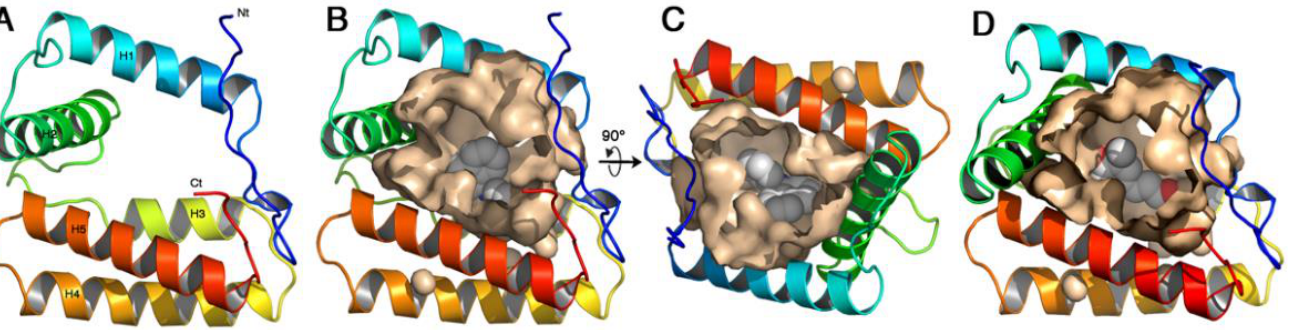
Figure 5. The homology model of TurtOBP1 obtained with Swiss-Model homology modeling [44]. ( A ) Ribbon view of the overall fold with its five α -helices. Colors are in rainbow mode from blue (N-terminus) to red (C-terminus). ( B ) View of TurtOBP1 ribbon with the internal cavity walls and a 1-NPN molecule docked inside. ( C ) Same view 90° from view b. View made with PyMOL (https://pymol.org/ (accessed on 15 March 2021)). ( D ) The homology model of TurtOBP1 showing the internal cavity with coniferyl aldehyde docked inside [45]. View made with PyMOL (https://pymol.org/ (accessed on 16 March 2021)).